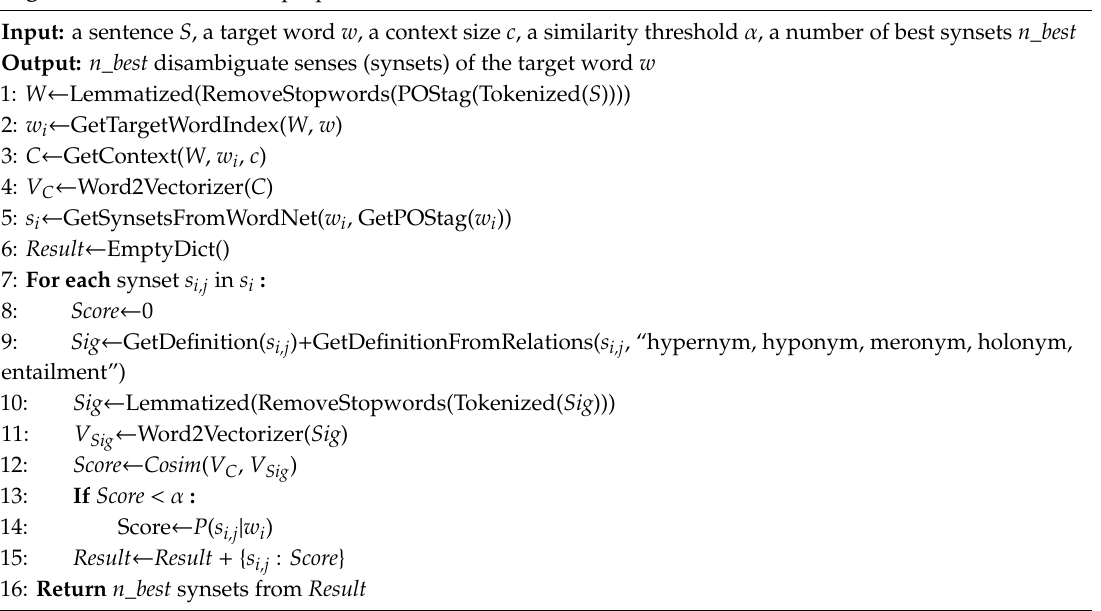
Algorithm 1 Pseudocode of proposed method,